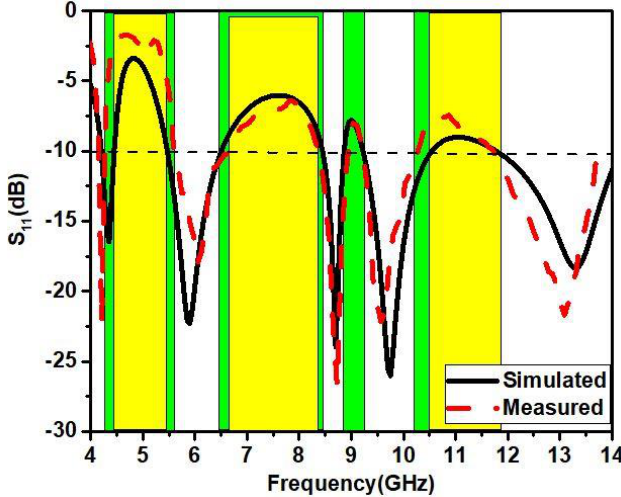
Figure 35. Simulated and measured S 11.